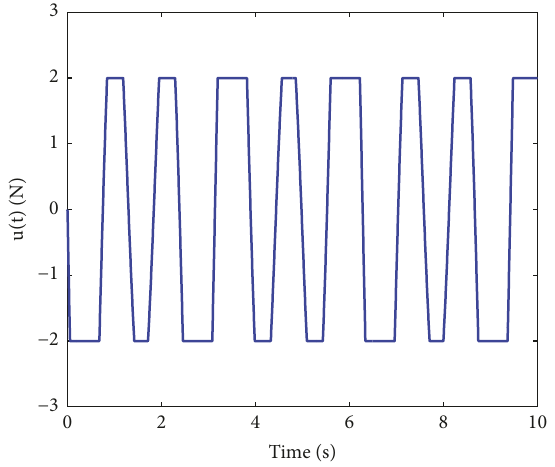
Figure 8: Saturated control input 𝑢(𝑡)